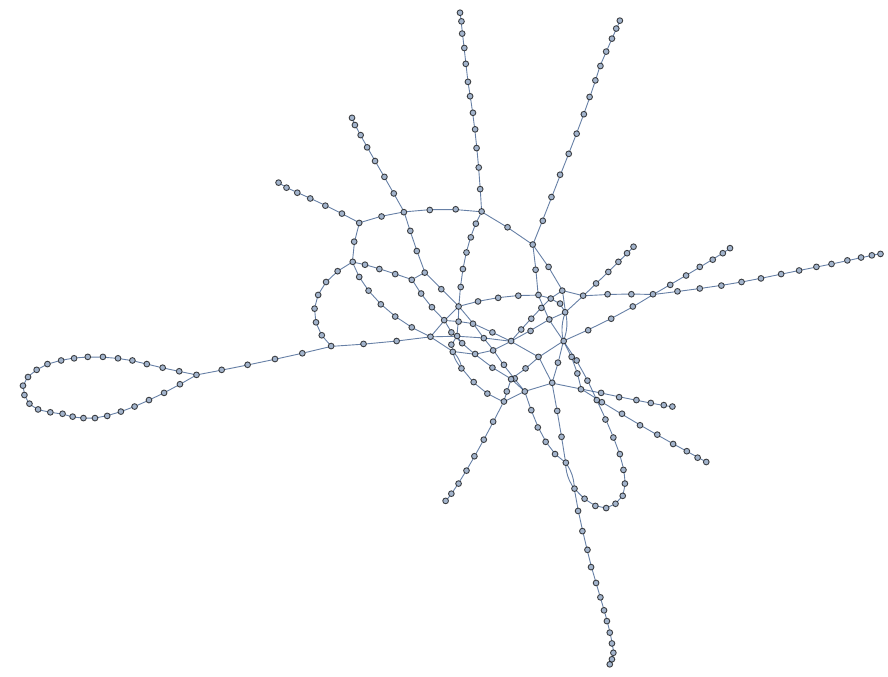
Figure 1. Madrid metro network computed using